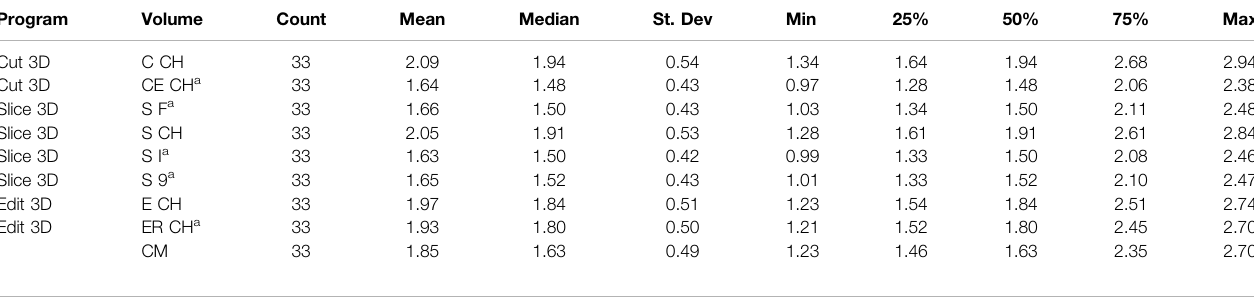
TABLE 2 | Data summary (unit of measure in dm 3 ).